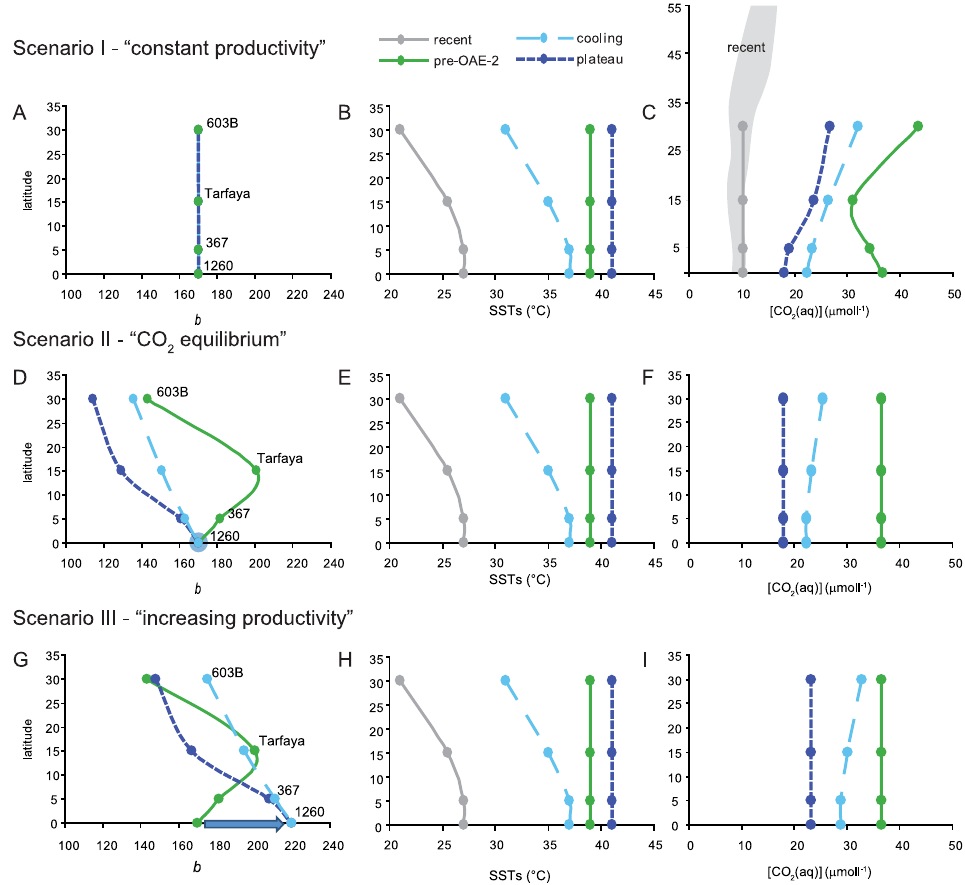
Fig. 5. Scenario (I) where [CO 2 (aq)] is calculated using b =170 (A) for all time slices. Sea surface temperatures are based on Sinninghe Damst´e et al., 2010 (B) . Values of [CO 2 (aq)] in µmoll − 1 (C) (Gray area indicates recent values from Goericke and Fry, 1994). Scenario (II) where b is allowed to vary (D) . Sea surface temperatures are based on Sinninghe Damst´e et al., 2010 (E) . Values of [CO 2 (aq)] in µmoll − 1 (F) . Scenario (III) where b is allowed to vary, with b increasing at the onset of OAE-2. (G) . Sea surface temperatures are based on Sinninghe Damst´e et al., 2010 (H) . Values of [CO 2 (aq)] in µmoll − 1 (I)